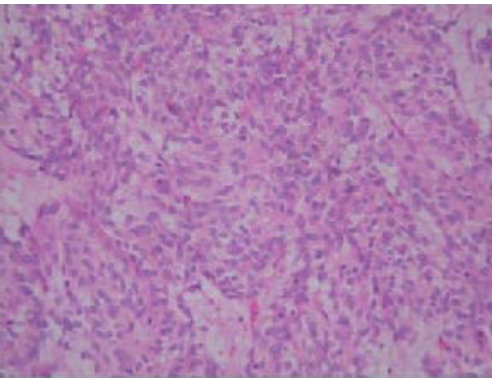
Figure 2: Photomicrograph (x200) of the original resection speci- men showing a cellular and epithelioid neoplasm.